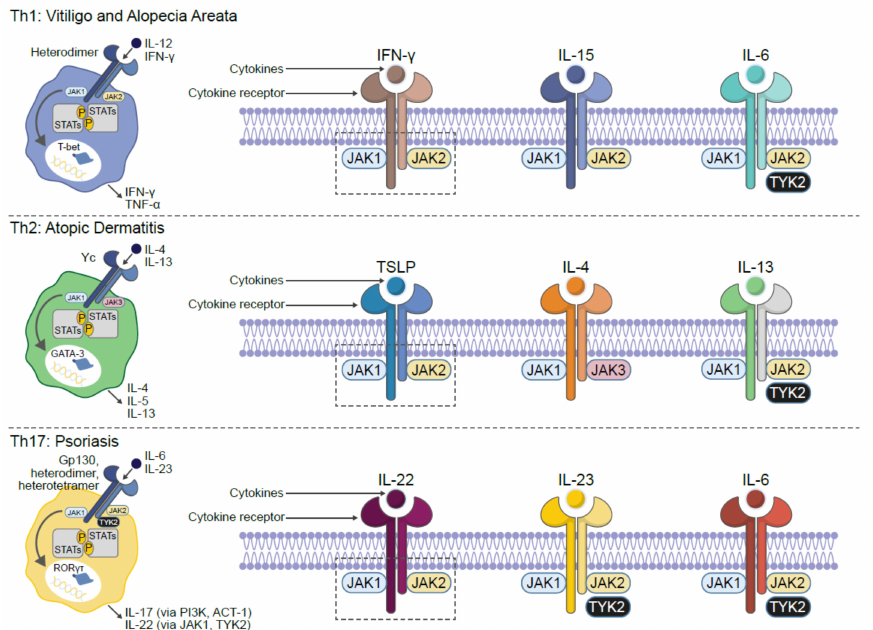
Figure 2. JAK-dependent inflammatory cytokines are implicated in the pathogenesis of multiple dermatologic diseases. ACT 1: NF- κ B activator 1; GATA: GATA binding protein-3; IFN: interferon; IL: interleukin; JAK: Janus kinase; PI3K: phosphoinositide-3-kinase; ROR: retinoid-related orphan receptor; STAT: signal transducer and activator of transcription; TYK: tyrosine kinase. Figure adapted from reference [5].